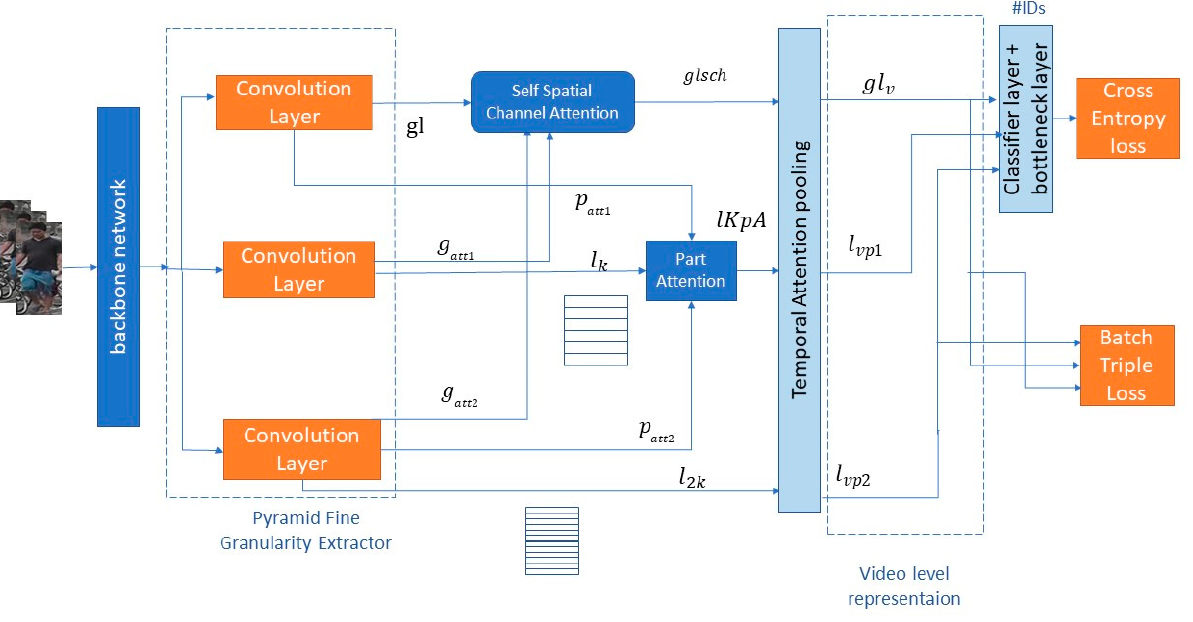
Figure 1. Overall Architecture of the System.